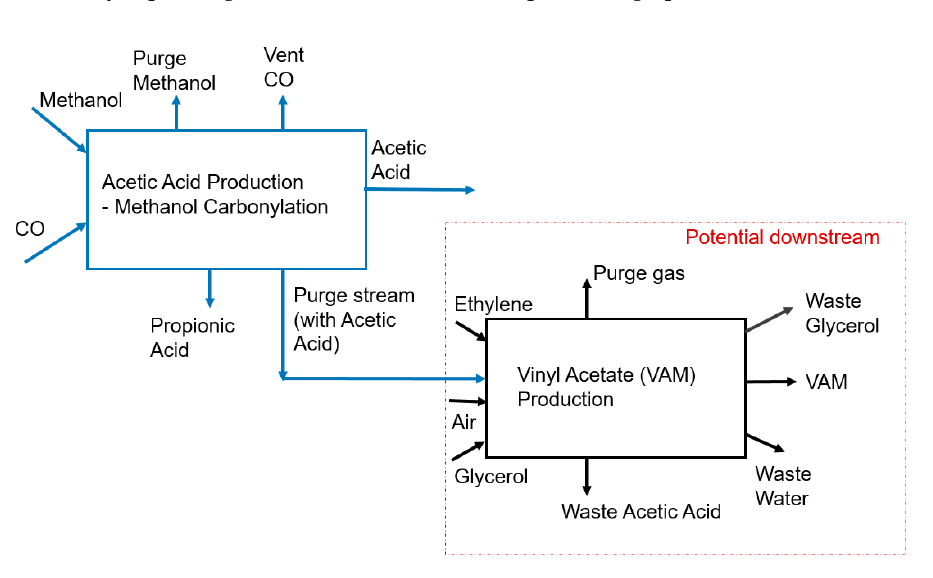
Figure 6. Exergy profit evaluation of waste acetic acid stream.